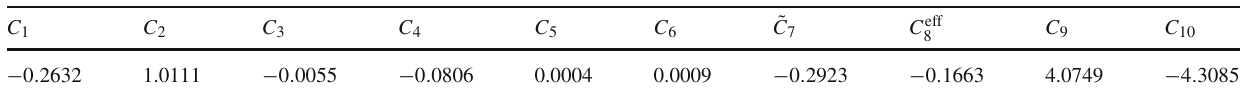
( C + 4 C 4 + 20 C 5 + 80 C 6 3 3 3 3